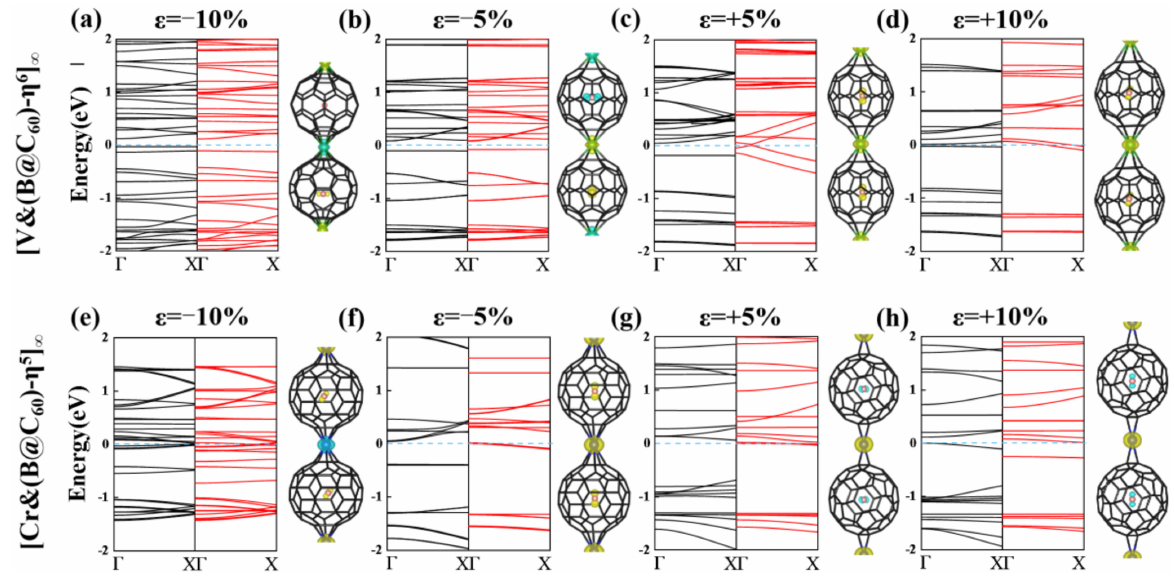
Figure 5. Band structures and spin density of 1D [V&(B@C 60 )- η 6 ] ∞ and ( b ) [Cr&(B@C 60 )- η 5 ] ∞ SMWs under several strains of − 10% ( a , e ), − 5% ( b , f ), +5% ( c , g ) and +10% ( d , h ); yellow and blue colors indicate up and down spins, respectively. The blue, black and red lines represent the Fermi level, the spin up and spin down electronic bands, respectively.